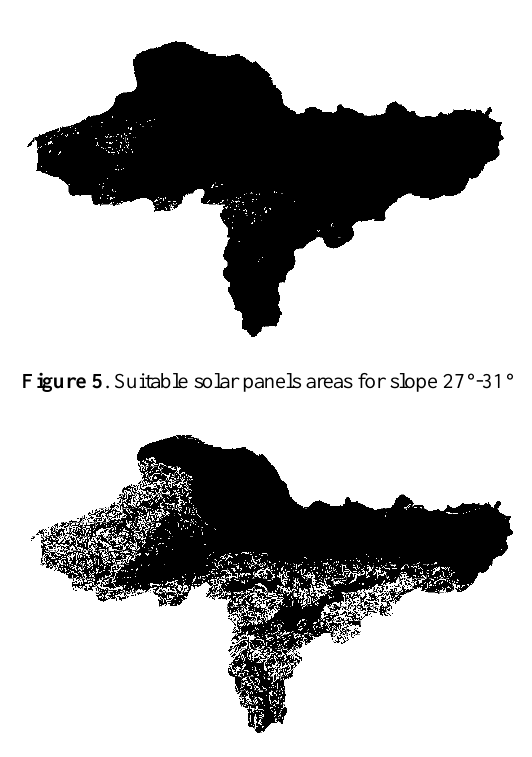
Figure 4 . Varaždinska county aspect model Based on calculations, optimal solar panel inclination for Republic of Croatia is 30° - 45°. Based on slope there have been areas calculated suitable for panels installation. Suitable areas are presented of Figure 5.